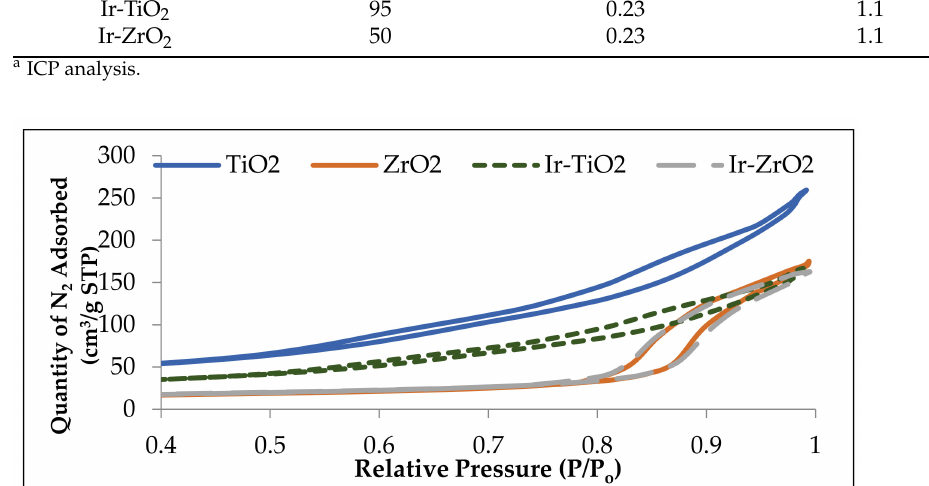
Figure 1. N 2 adsorption/desorption profiles of the